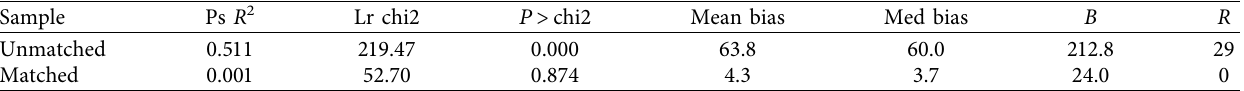
Figure 3: Unmatched and matched standardized % bias across covariates. Table 7: Post estimation of PSM.